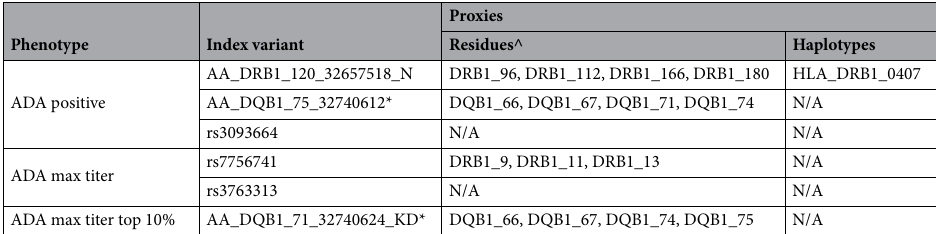
Table 2. Proxies (LD r 2 > 0.9) for MHC region index variants. *Same LD cluster. ^Residues affected by non- synonymous